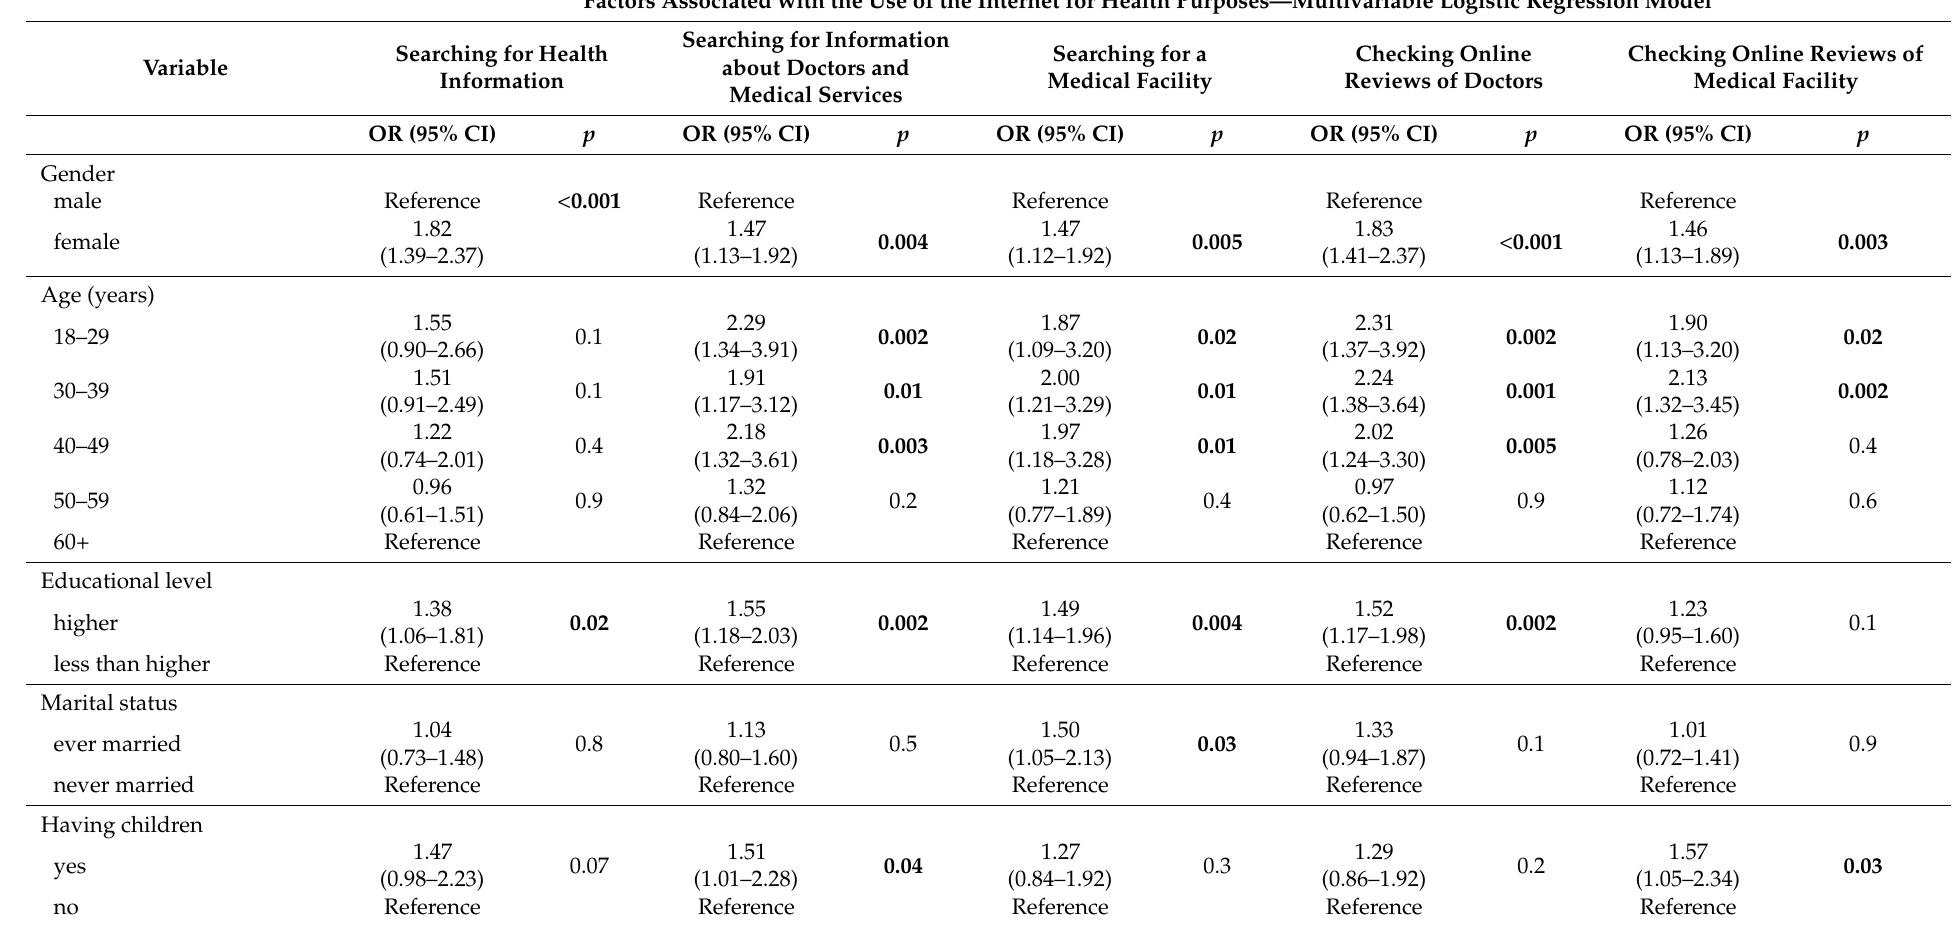
Table 3. Factors associated with the use of the Internet for health purposes (n = 1092). Factors Associated with the Use of the Internet for Health Purposes—Multivariable Logistic Regression